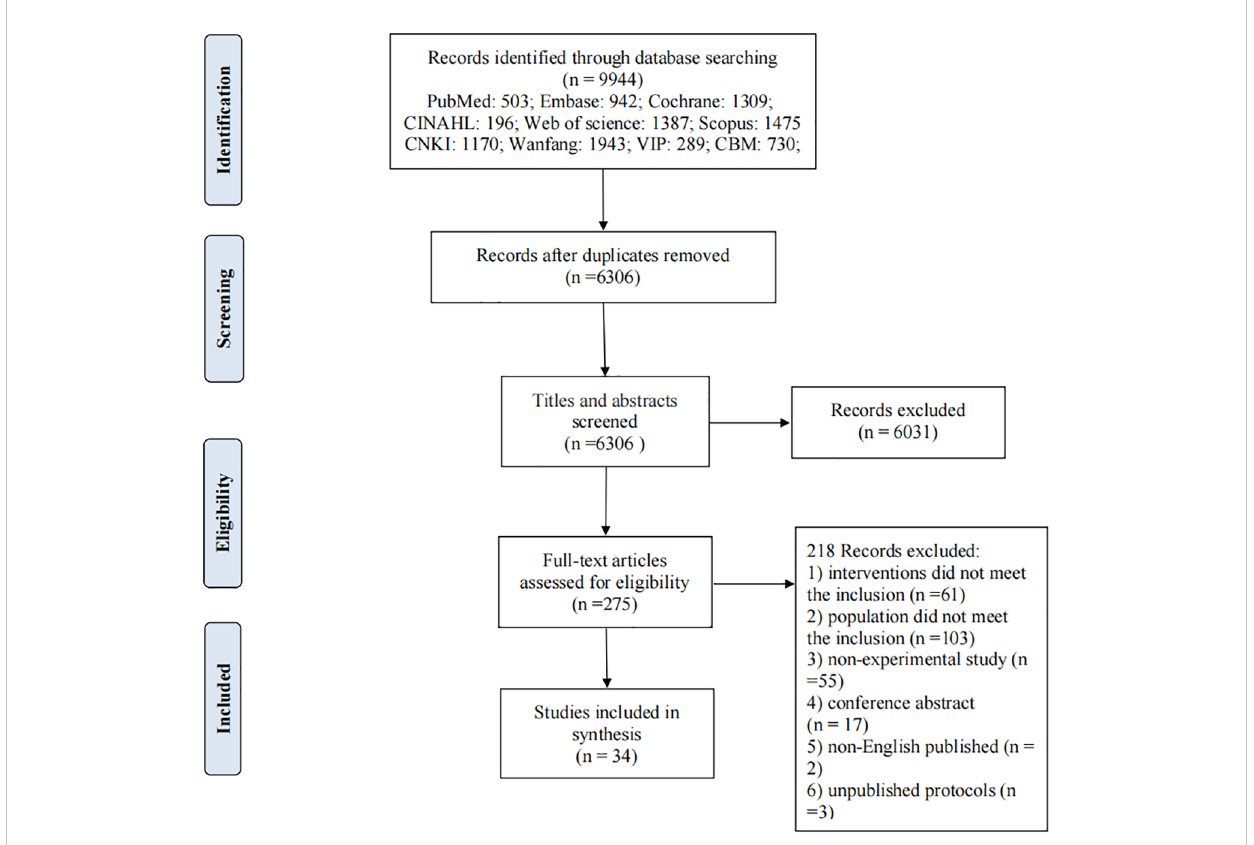
FIGURE 1 PRISMA fl ow